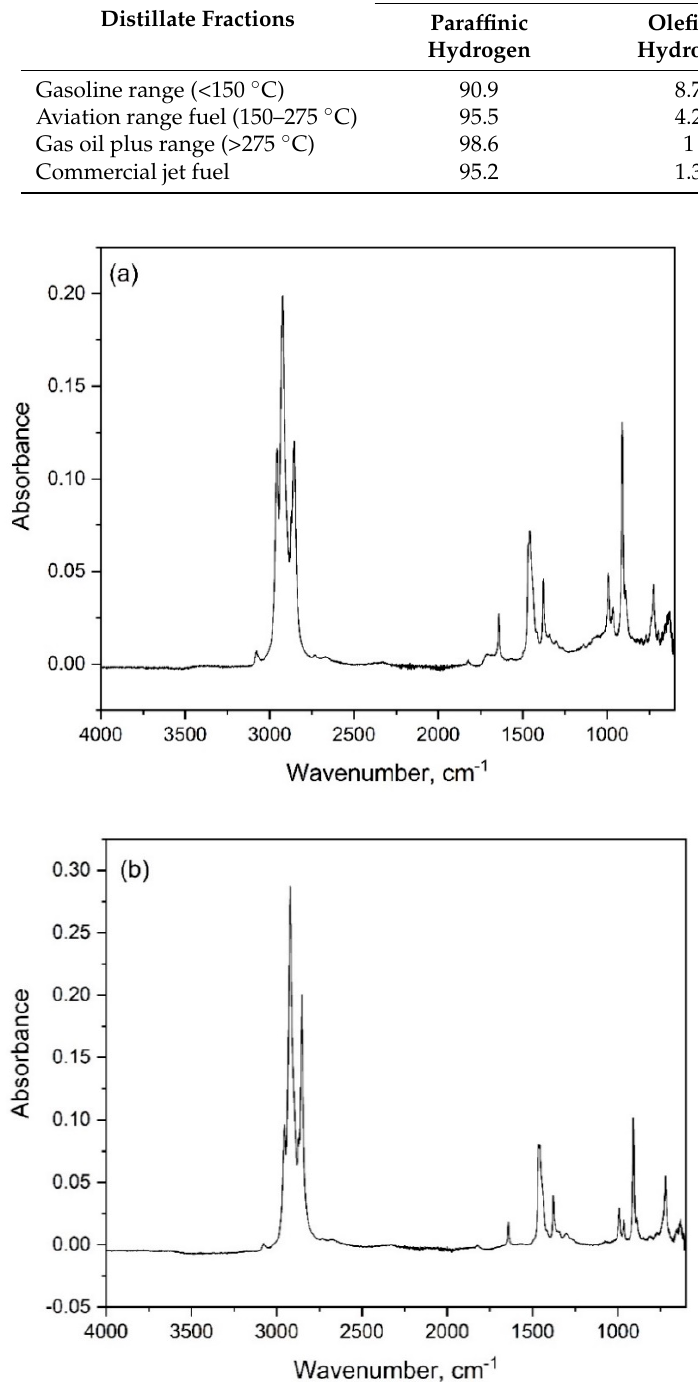
Table 8. Hydrogen distribution of the distillate fraction of plastic crude oil obtained after pyrolysis of landfill liner plastic waste (PCO-LL). Hydrocarbon Composition, Distillate Fractions